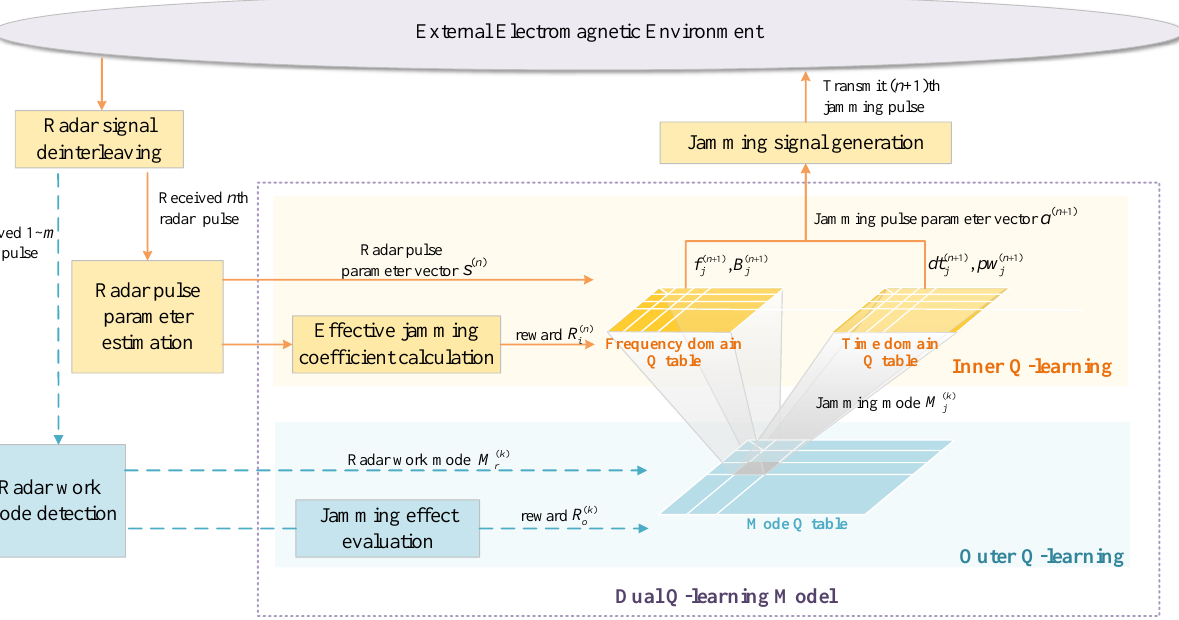
( k ) r is ( k ) is chosen and map j